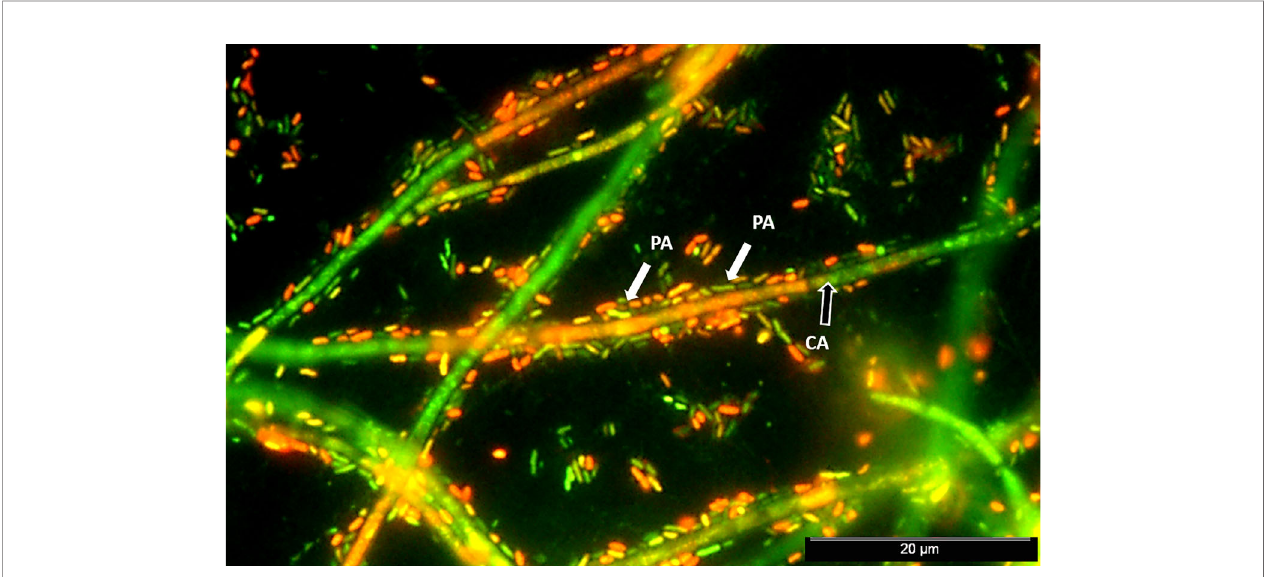
FIGURE 1 | Mixed P. aeruginosa-C. albicans 24 h – old bio fi lm. Epi fl uorescence image of a stained bio fi lm with a mixture of SYTO ® BC and propidium iodide (PI) (Invitrogen ™ , CA, USA) shows P. aeruginosa PAO1 (PA) cells (highlighted by white arrows) surrounding and colonizing in a great extension the C. albicans SC5314 (CA) hyphae (black arrow). Cells were prepared at approximately 10 7 CFU/mL in RPMI 1640 media and mixed in equal proportions. Mixed suspensions were transferred to Thermanox ® plastic coverslips, placed in 24-well plates, and incubated at 120 rpm and 37°C for 24 h prior to bio fi lm